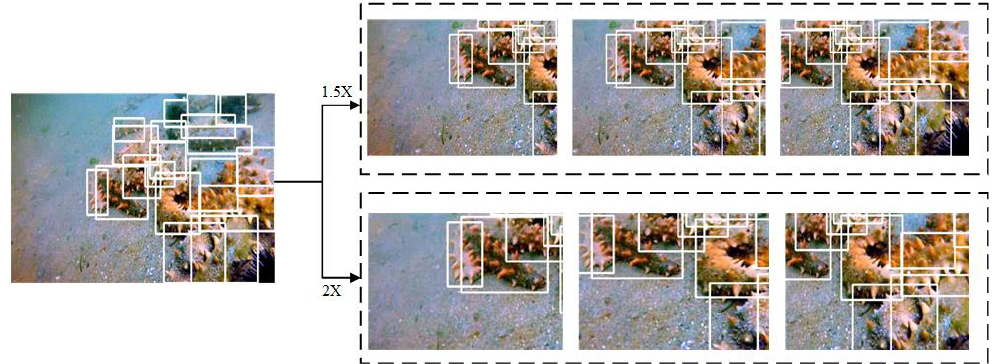
Figure 5. Instance-Balanced Augmentation algorithm.